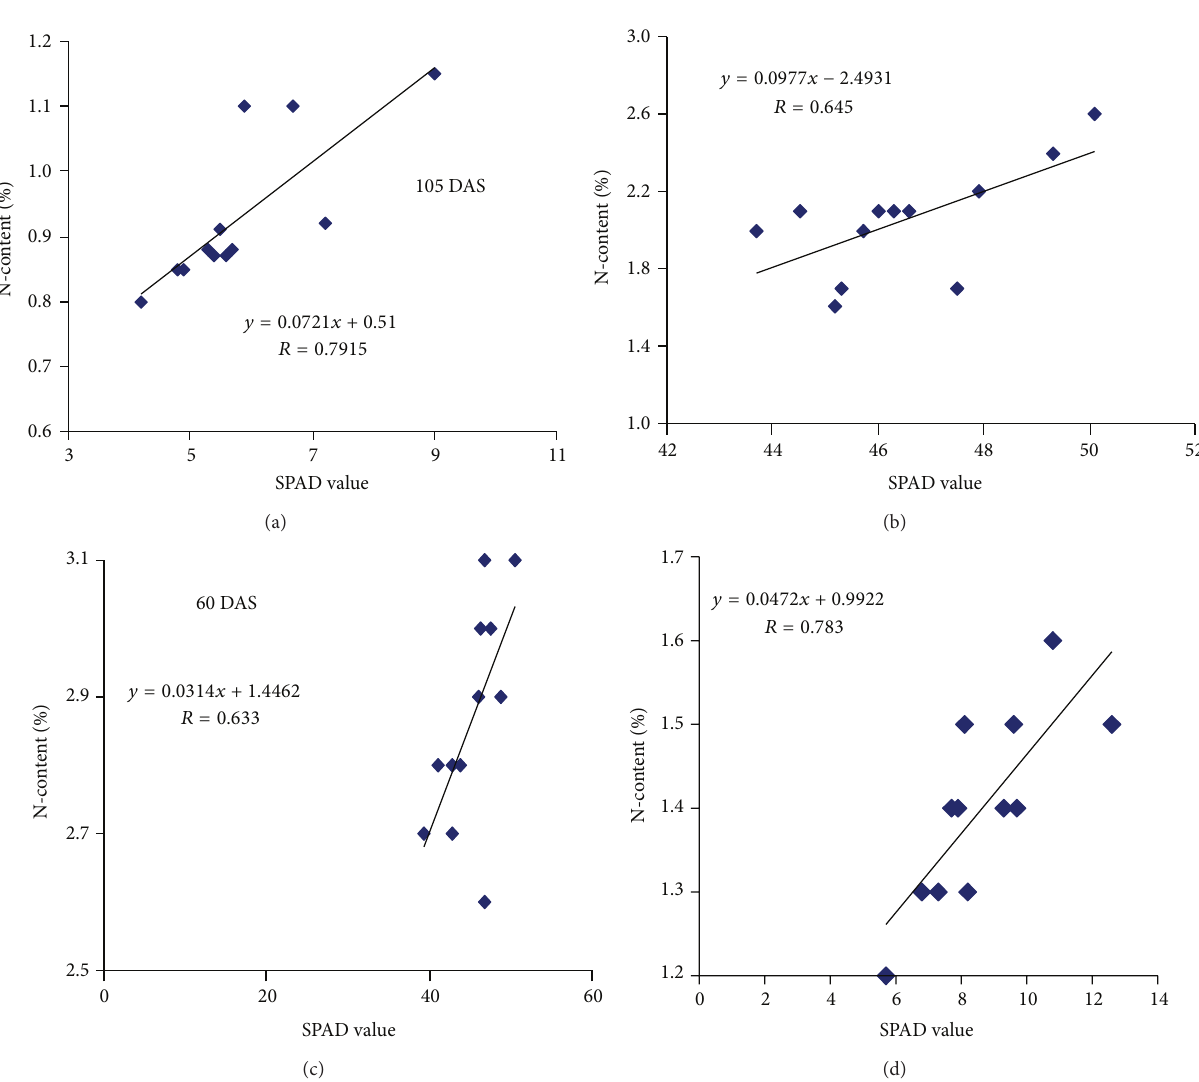
Figure 7: Relationship between SPAD values and N-content at different growth stages of maize